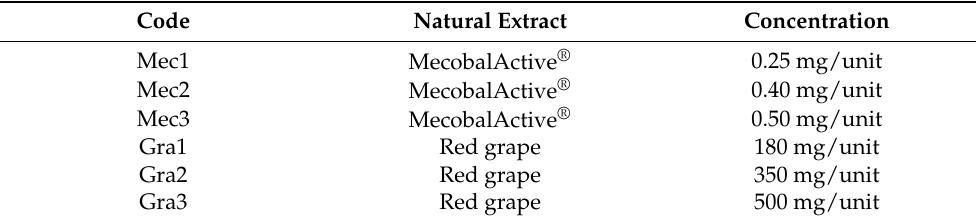
Table 1. Concentration of active extracts in each experimental sample.